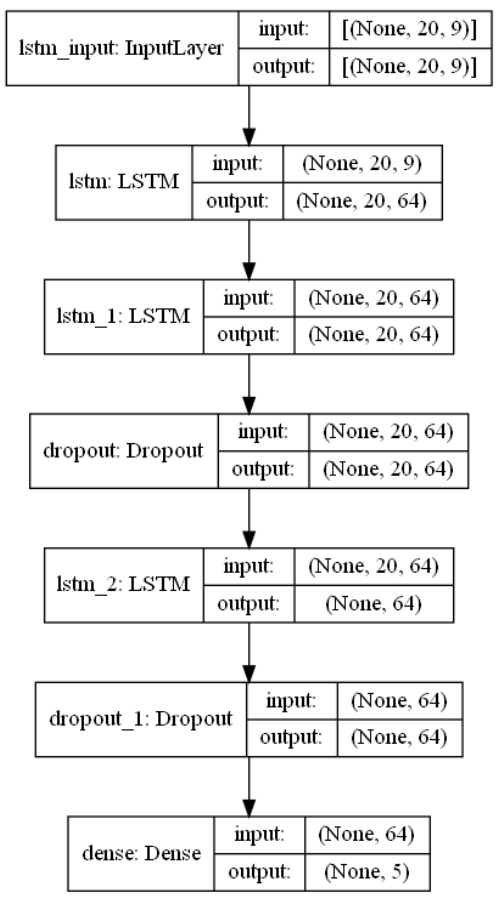
Figure 4. LSTM model summary— A6 Run (five multisteps).